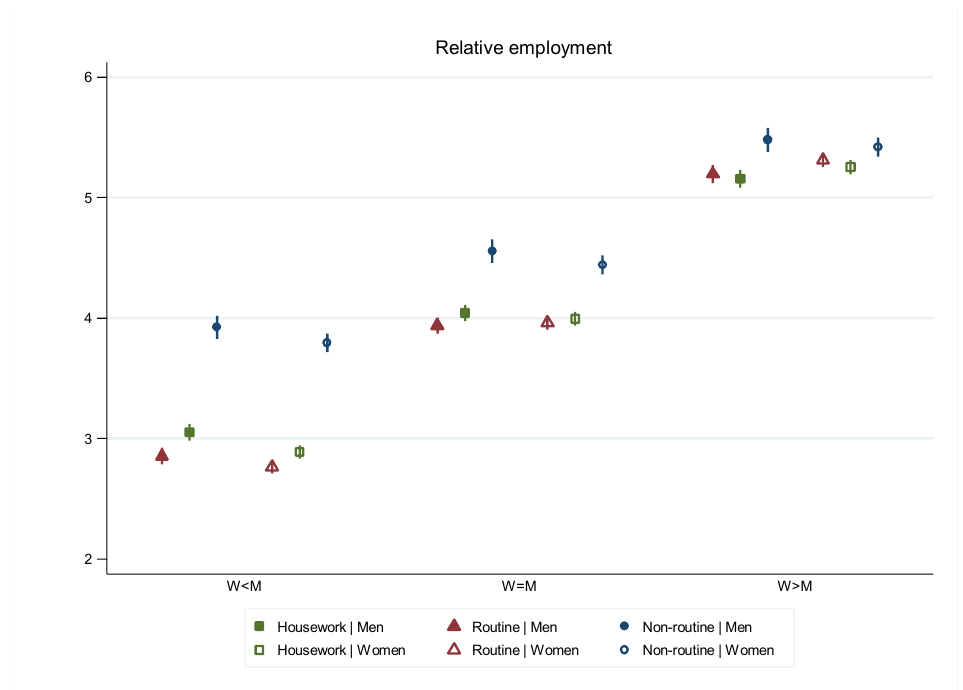
Figure B.3 : Predicted attitudes towards housework by vignette couples’ relative